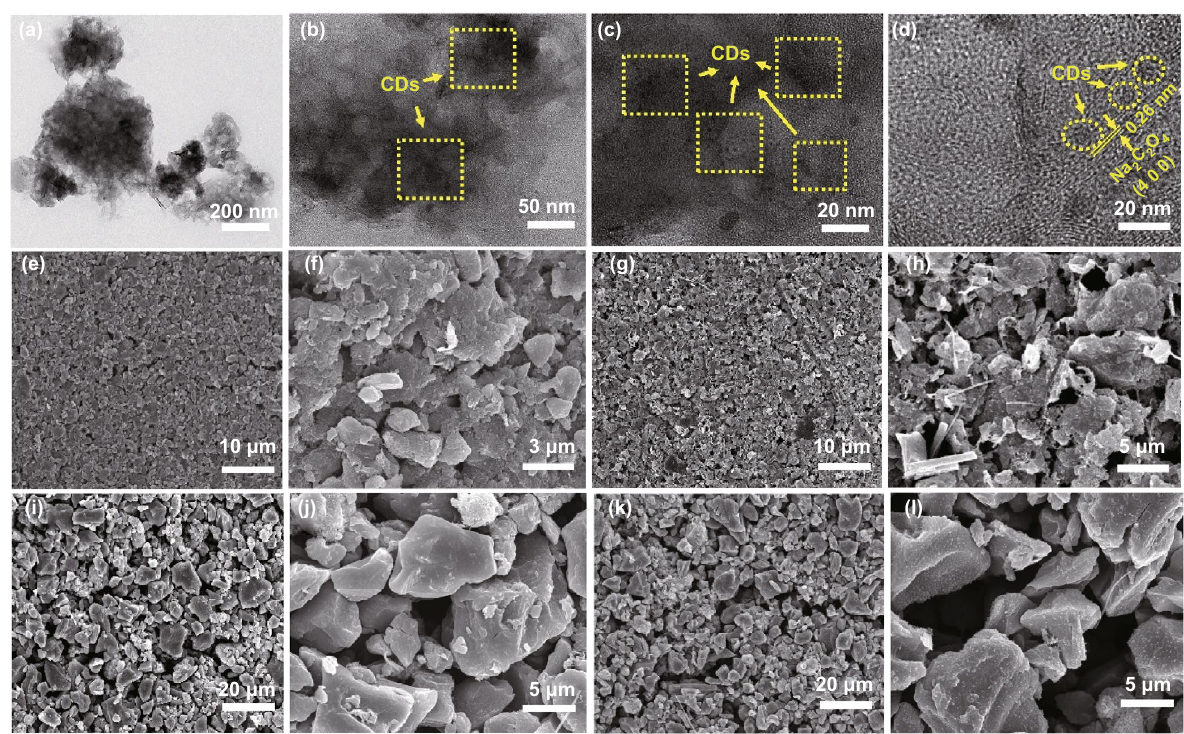
Fig. 5 a - c TEM images of NCO-S-3D. d HRTEM image of NCO-S-3D. SEM images of decomposition characteristics of AC + NCO with dou- ble coating method before ( e, f ) and after ( g, h ) cycles. Surface images of AC + NCO with traditional slurry method before ( i, j ) and after